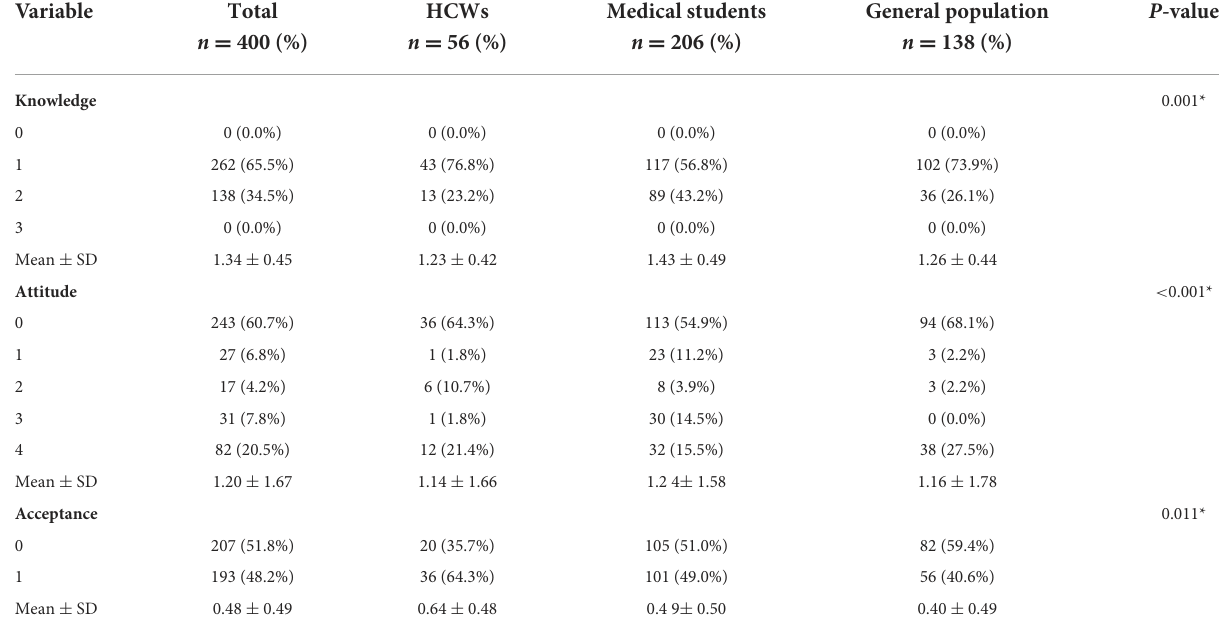
TABLE 2 Knowledge, attitude, and acceptance scores by